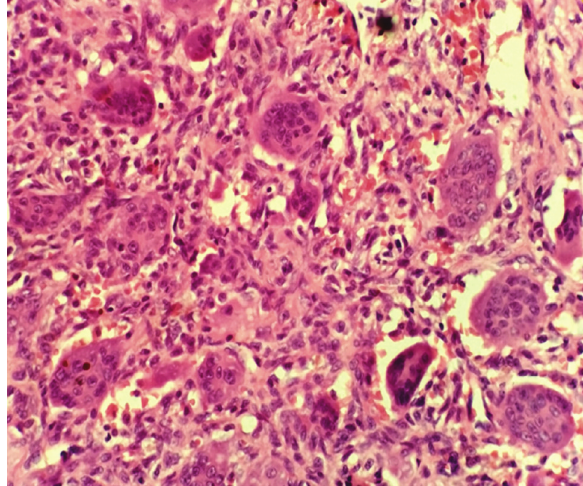
Photo-micrograph of the tumour showing monotonous Fig. 3: spindle cells amidst many osteoclastic giant cells (hematoxyline and eosin stain, x40).